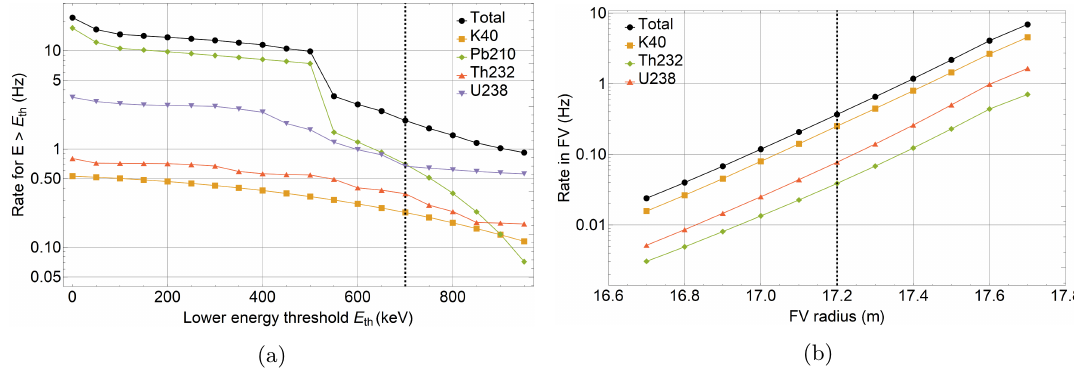
Figure 5. (a) Expected count rates in DV due to the residual contaminations of the LS (LS- reactor impurity inputs in table 1) as a function of the energy threshold E applied to the simulated th spectra. Solid lines connect the points to guide the eye. E = 0.7 MeV is the threshold energy value th chosen for the neutrino mass ordering analysis by JUNO (shown by the dashed line). (b) Expected background count rates for E = 0.7 MeV due to uniform 40 K, 232 Th, and 238 U contaminations th in the bulk of the acrylic sphere as a function of different radius quotes r chosen to define the LS experimental FV. Solid lines connect the points to guide the eye. Currently, the default JUNO FV for anti-neutrino analysis is spherical, with radius r = 17.2 m (shown by the dashed LS